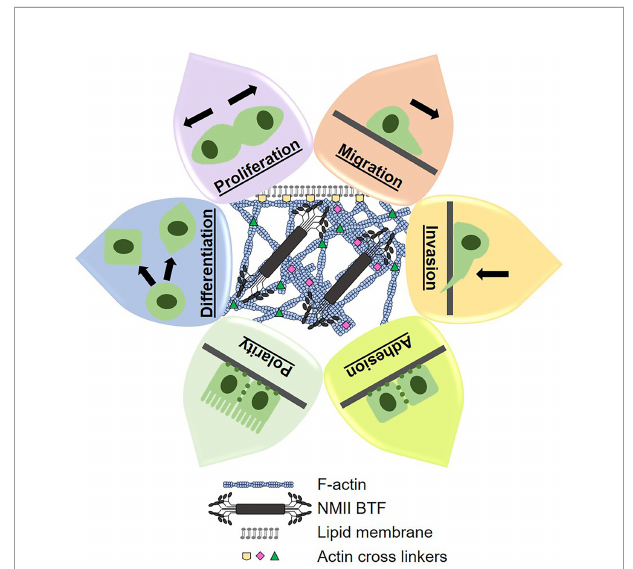
FIGURE 1 | Cytoskeletal dynamics control cortical mechanics, morphogenesis, and cell behavior. The cytoskeletal components of fi lamentous actin (F-actin), actin crosslinking proteins, and non-muscle myosin II bipolar thick fi laments (NMII BTF) dynamically assemble, polymerize, and depolymerize to generate whole cell mechanical properties and cell shape. Mechanical properties and cell shape change underlie the cell behaviors that we observe and measure. Therefore, we can manipulate cell behaviors by altering cortical mechanics and cytoskeletal dynamics, which lends great therapeutic